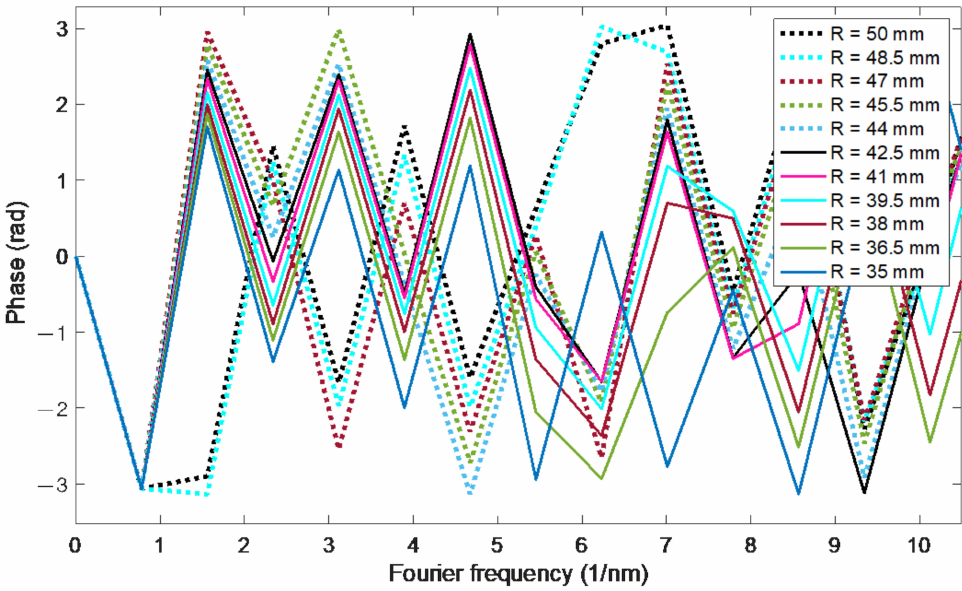
Figure 12. Fourier phase spectra corresponding to the optical spectra from Figure 10 for bending radii from 35 to 50